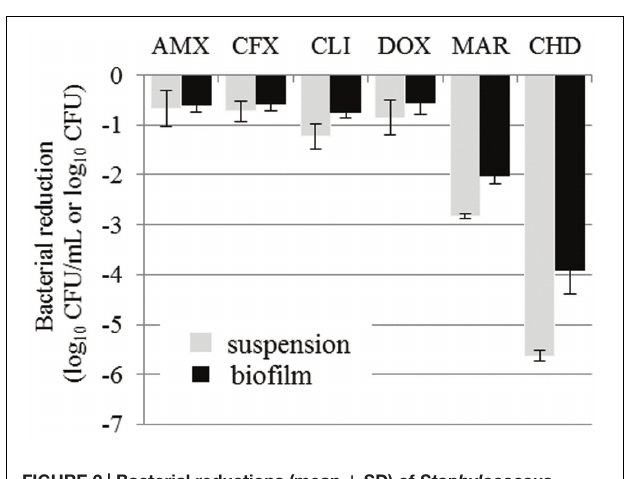
FIGURE 2 | Bacterial reductions (mean ± SD) of Staphylococcus pseudintermedius suspension (gray bars, in log 10 CFU/mL) and biofilm (black bars, in log 10 CFU) after 15-h exposure to amoxicillin (AMX), cefalexin (CFX), clindamycin (CLI), doxycycline (DOX), or marbofloxacin (MAR) or after 5- min exposure to chlorhexidine